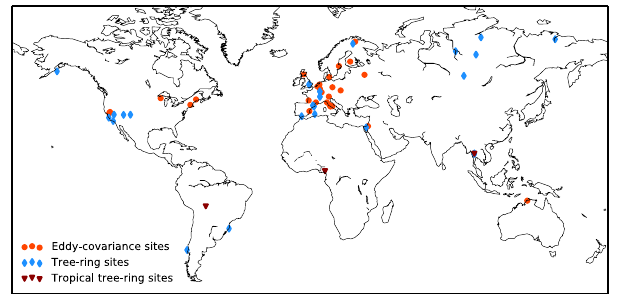
Figure 1. Locations of the eddy covariance flux sites and tree-ring sites used (see Table S2 and S3 in the Supplement for a list of the sites). Tropical tree-ring sites are used as independent data sources for